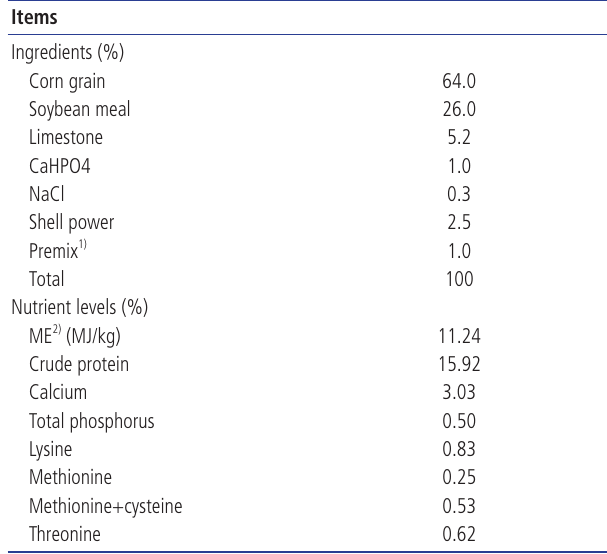
Table 1. Composition and nutrient levels of the basal diets (g/kg, unless otherwise stated) Items Ingredients (%) Corn grain Soybean